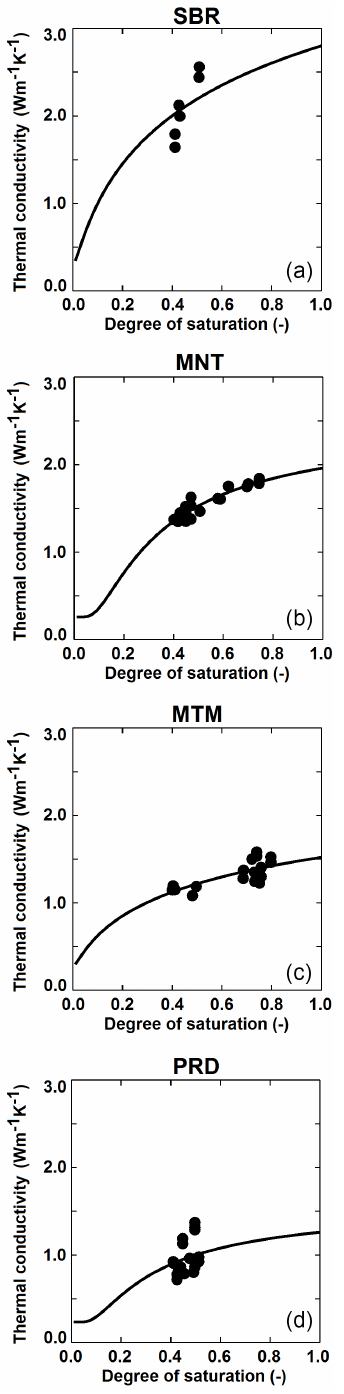
Figure 3. Retrieved λ values (dark dots) vs. the observed degree of saturation of the soil at a depth of 0.10m for (from top to bottom) Sabres (SBR), Montaut (MNT), Mouthoumet (MTM) and Prades- le-Lez (PRD), together with simulated λ values from dry to wet conditions (dark lines).